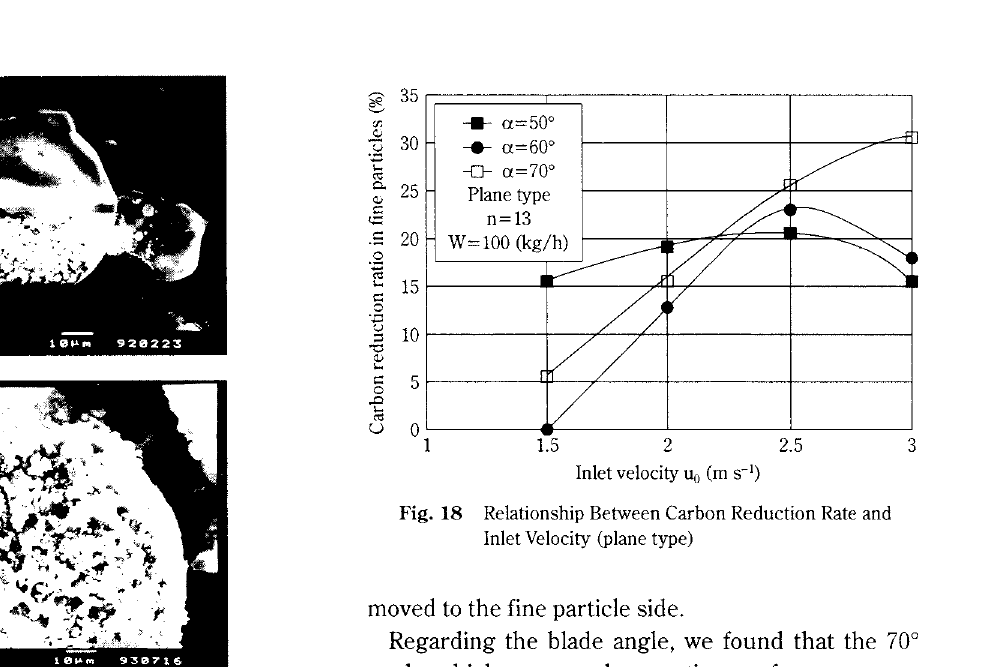
Fig. 18 Relationship Between Carbon Reduction Rate and Inlet Velocity (plane type) moved to the fine particle